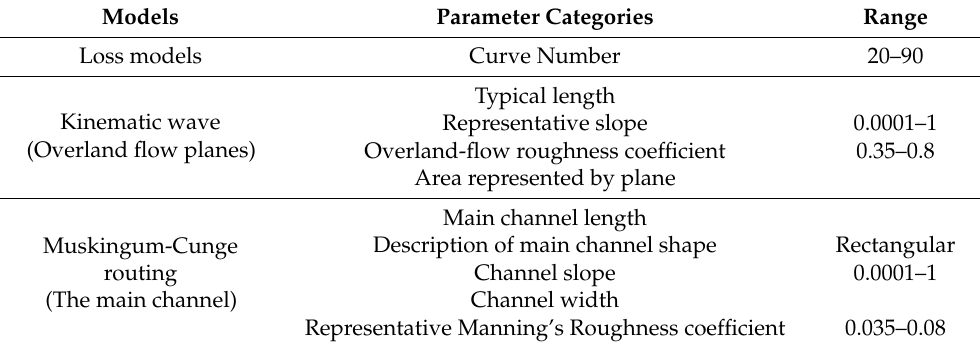
Table 1. Model parameter categories and their available ranges